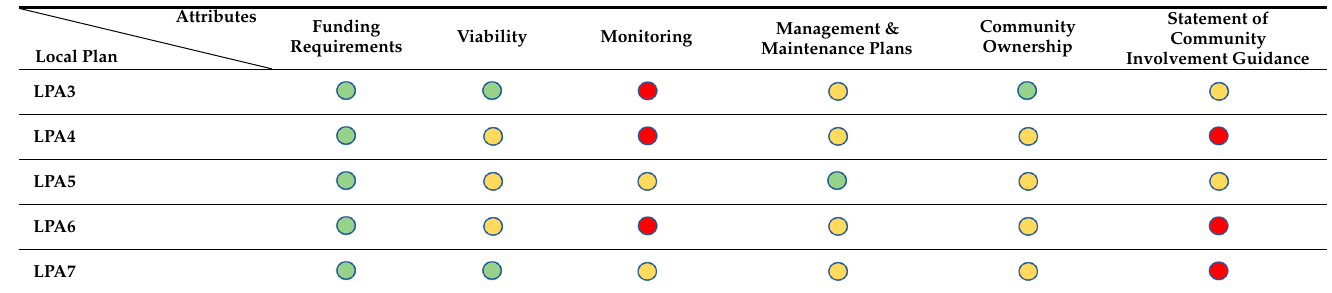
Table 3. Local plans and health requirements for developers.